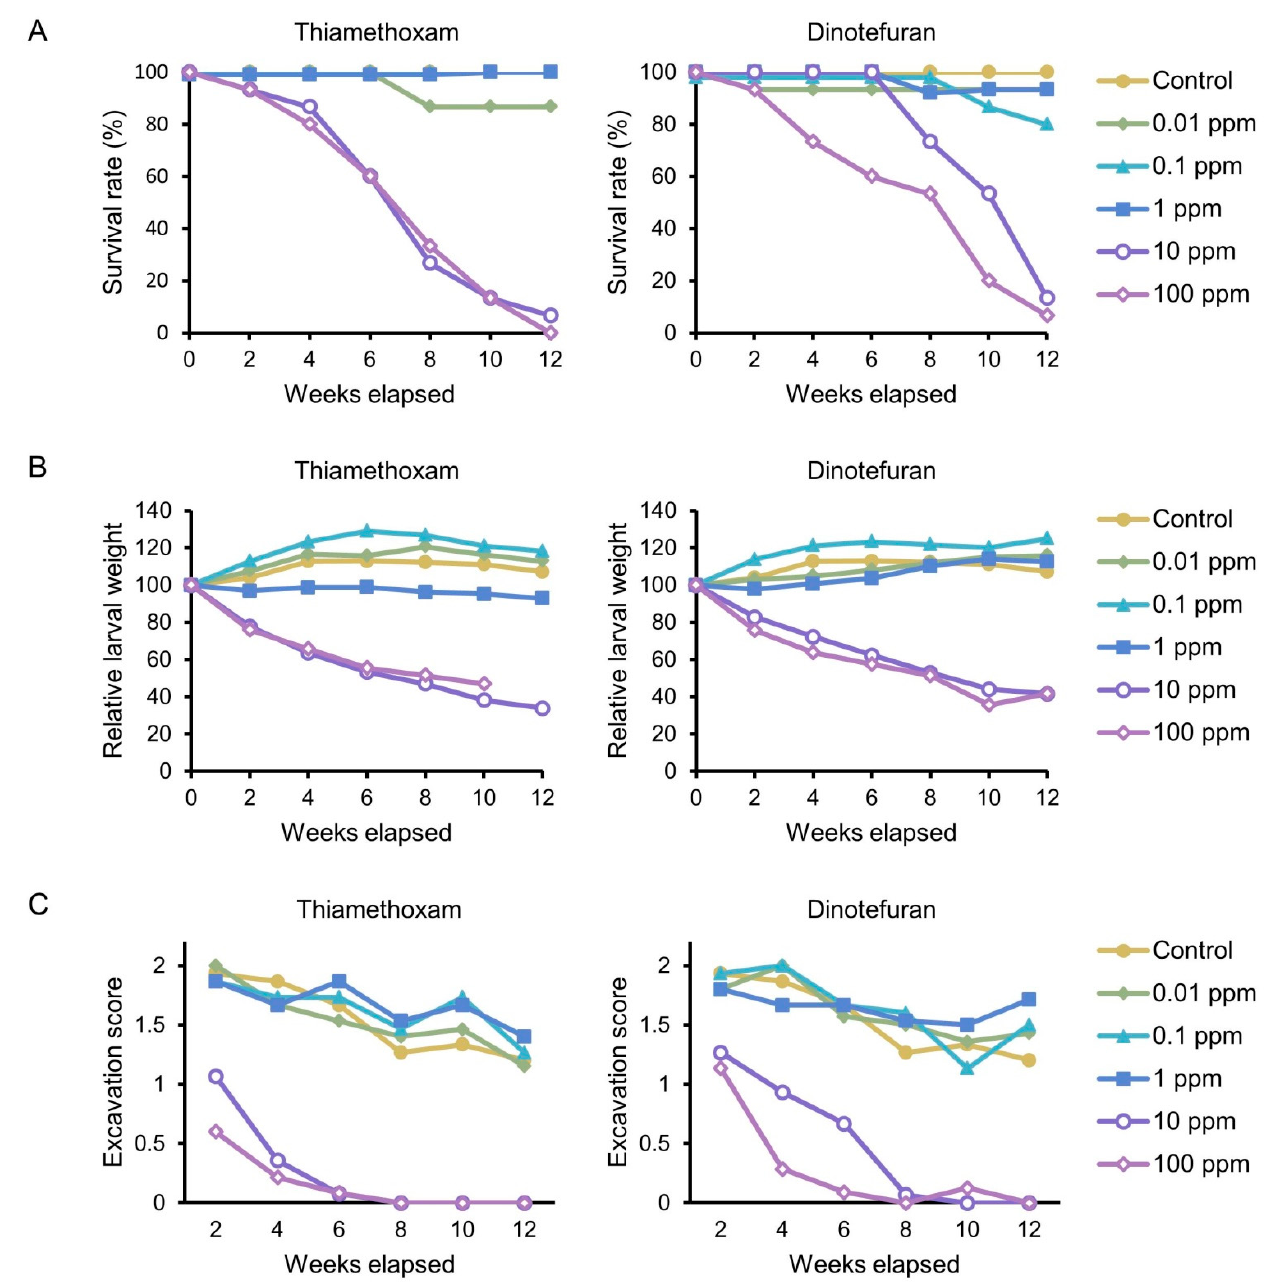
Figure 4. Results of dietary toxicity test against Aromia bungii late instar larvae. ( A ) Survival rate. ( B ) Weight change. The relative weight is shown with an initial individual weight as 100. ( C ) Diet excavation. See the explanation for excavation scores in Figure 1.